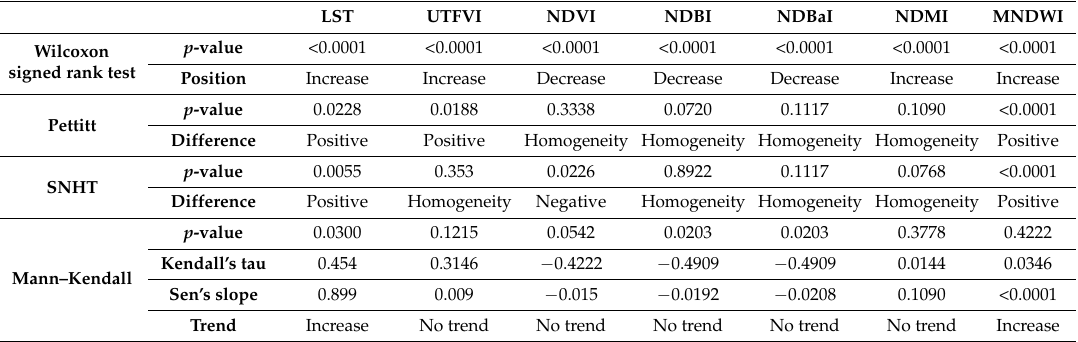
Table 10. Tests results for the Groupama Stadium on selected dates for median LST and spectral